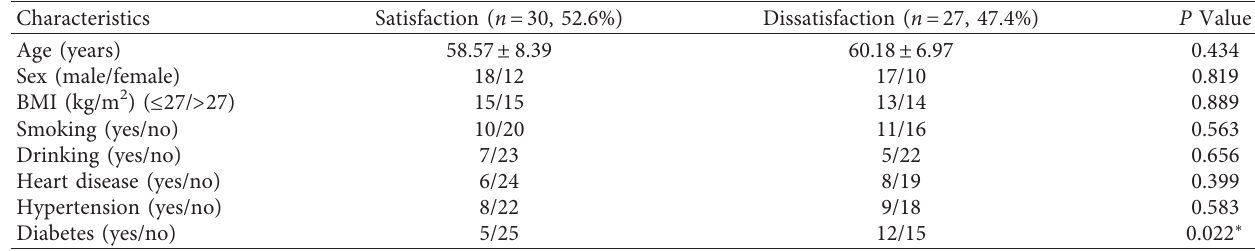
Table 3: The main demographic variables in the satisfied and dissatisfied patients at